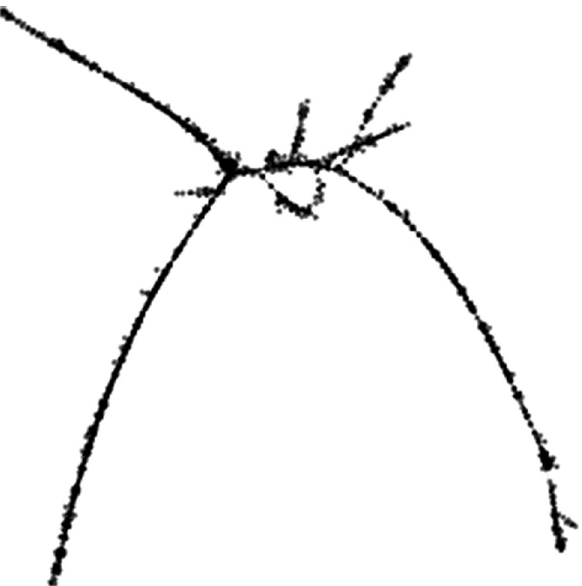
Figure 2. PRW LINE-like RepeatExplorer graph. Graph layout for cluster 32 generated by RepeatExplorer. Nodes represent individual illumina reads and edges their sequence